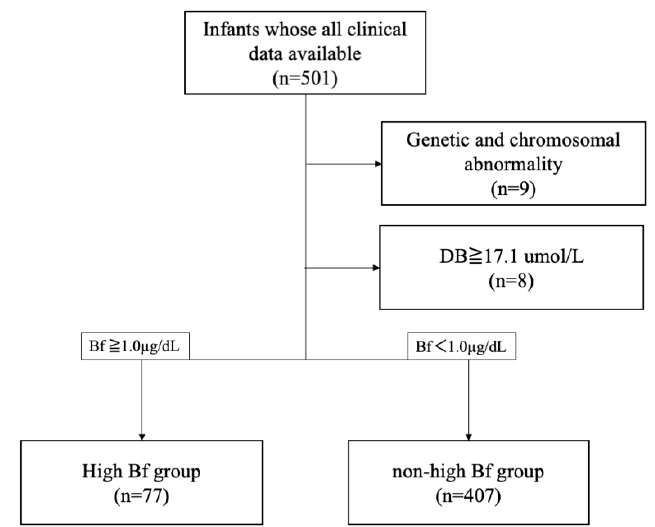
Figure 1. Patient enrollment. Bf, free bilirubin; DB direct bilirubin. Table 1. Clinical